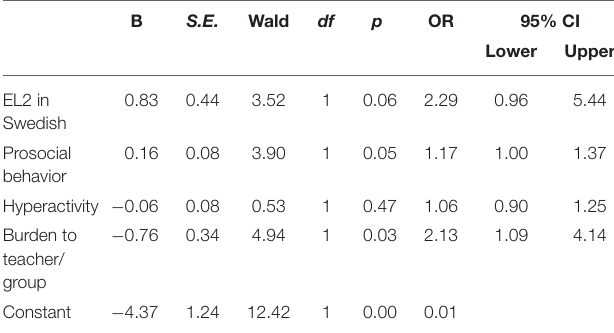
TABLE 6 | Logistic regression model assessing the probability of receiving no